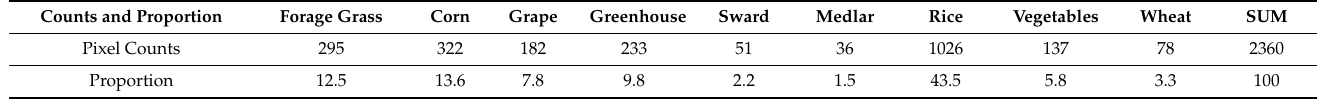
Table 5. The number of training samples and the proportion of each crop type in 2017 for 100 m PROBA-V. Counts and Proportion Forage Grass Corn Grape Greenhouse Sward Medlar Rice Vegetables Wheat SUM Pixel Counts